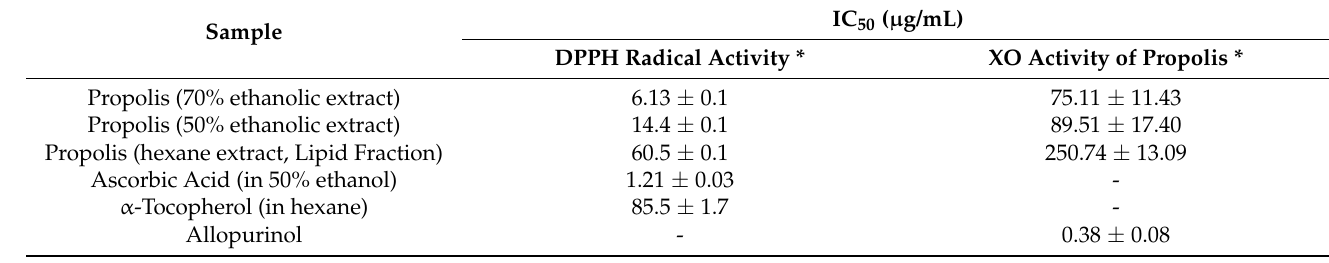
Table 4. In vitro DPPH radical scavenging and XO activity of